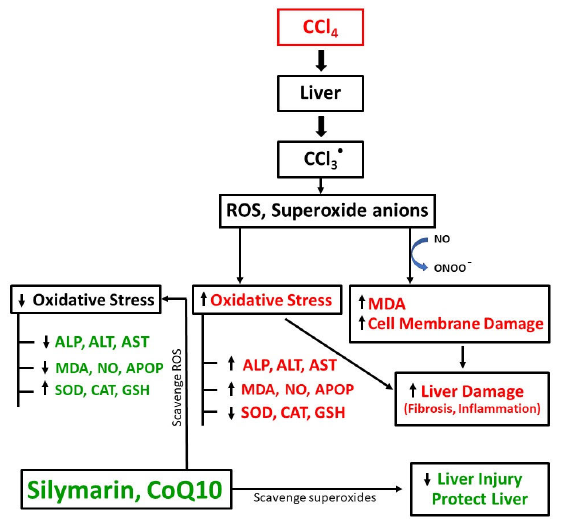
Figure 7. Schematic diagram of CCl 4 -induced pathogenesis of liver damage and protective role of CoQ10 and silymarin.